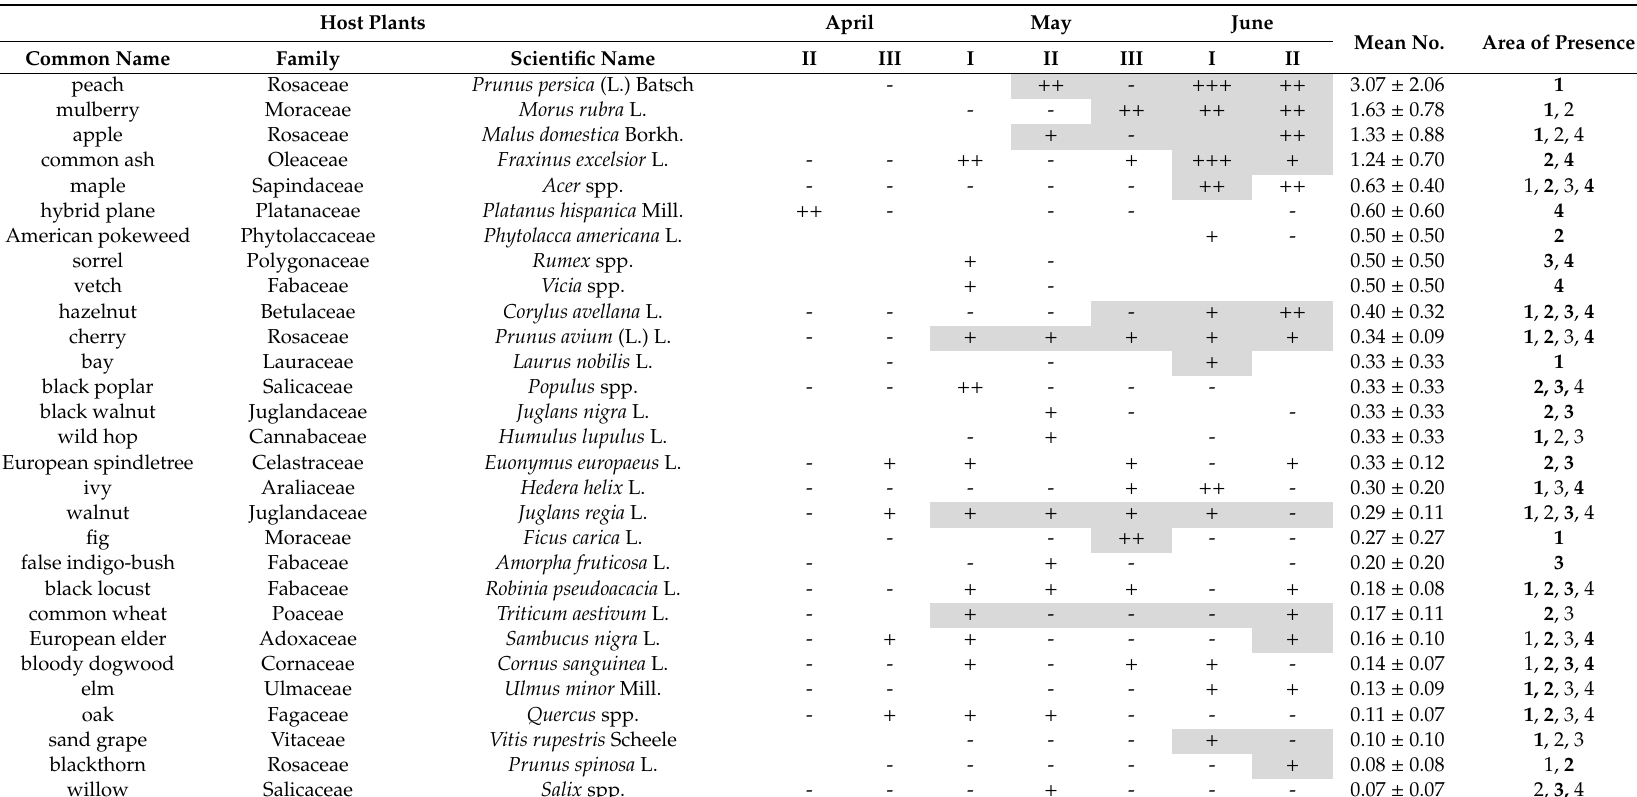
Table 3. Mean numbers ( ± SE) of Halyomorpha halys adults per plant and per sampling period, collected on host plants in the four study areas from mid-April to mid-June. Abundance of H. halys referred to each 10-day period is given as qualitative index as follows: - = absence; + = 0.1–1; ++ = 1.1–4; +++ ≥ 4.1 mean adults / plant (sampling unit). Shading indicates the fruiting period of plants. Areas in which plants were sampled are also given; bold areas indicate the presence of bugs on the plant in that